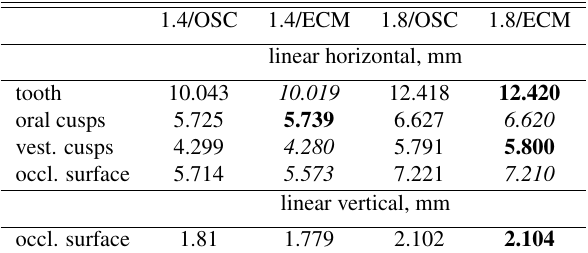
Table 1. Linear measurements for teeth oriented in the two modes (OSC and